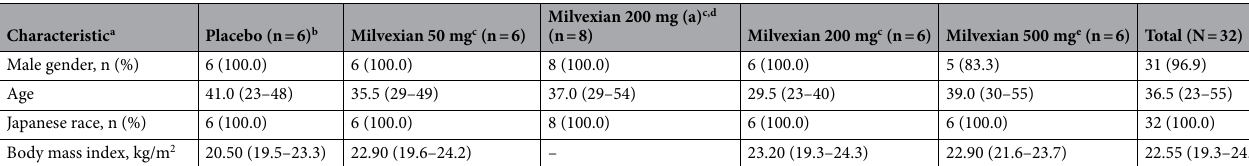
Table 1. Baseline characteristics for all treated participants PK, pharmacokinetics. a All values presented as median (minimum–maximum) unless otherwise stated. b One participant in Cohort 3 (milvexian 500 mg or placebo) assigned to placebo was discontinued early due to participation in multiple clinical trials; this participant was excluded from analysis and replaced. c Milvexian 50 mg and 200 mg were administered under fasted conditions. d Cohort 2a, milvexian 200 mg (a), includes unblinded and early terminated participants from Cohort 2 (milvexian and placebo participants). These participants were excluded from the evaluable PK population. e Milvexian 500 mg was administered under fed